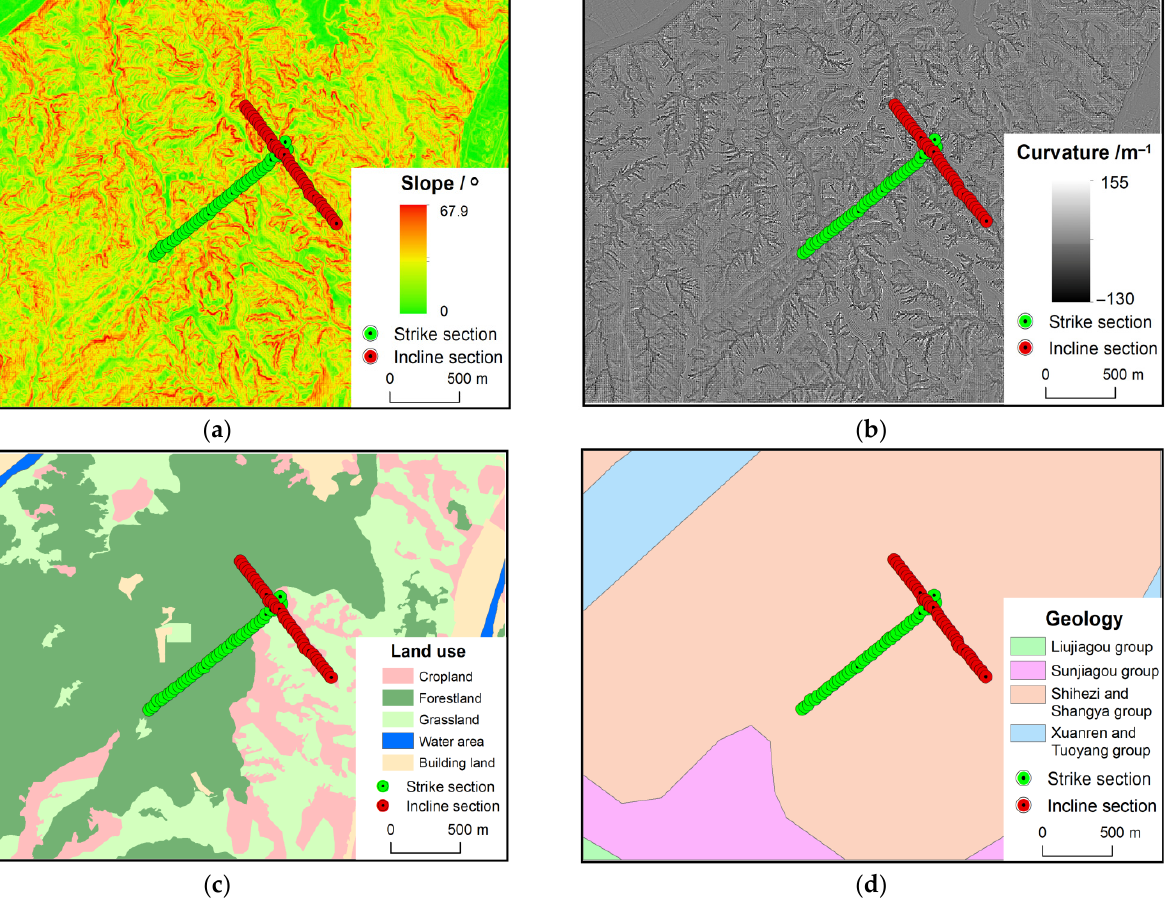
Figure 2. The characteristics of the study area: ( a ) slope; ( b ) curvature; ( c ) land use; ( d ) geology.